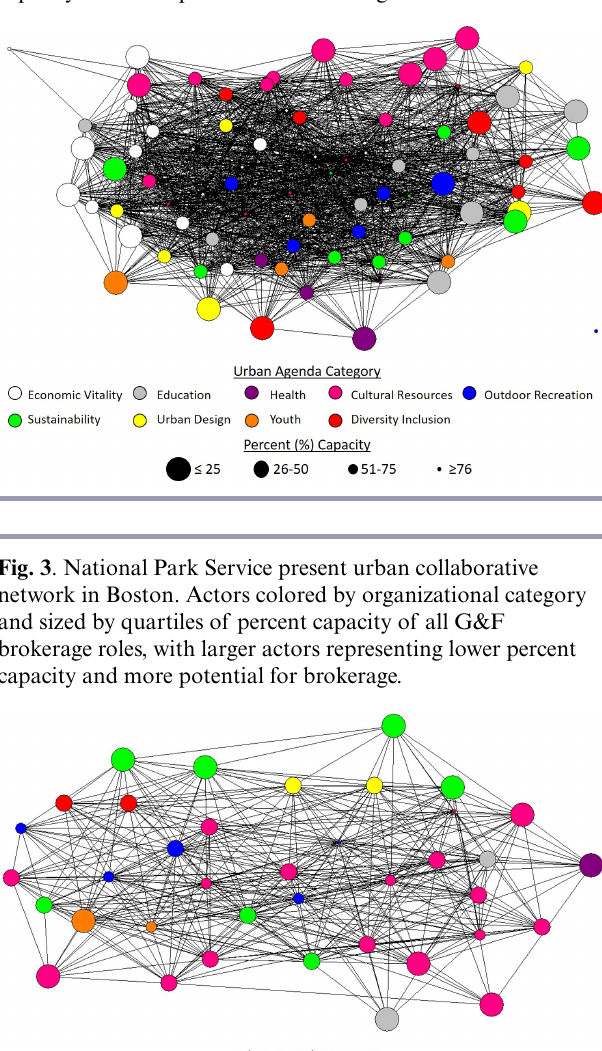
Fig. 2 . National Park Service present urban collaborative network in Tucson. Actors colored by organizational category and sized by quartiles of percent capacity of all G&F brokerage roles, with larger actors representing lower percent capacity and more potential for brokerage.